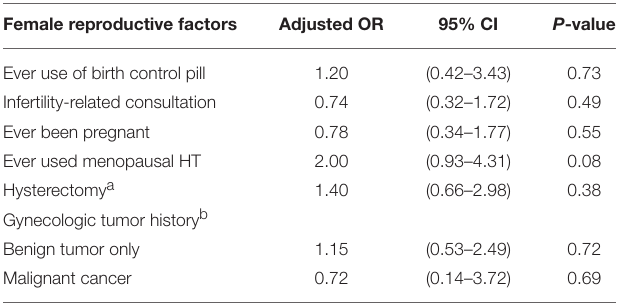
TABLE 3 | Age-adjusted comparison of key female reproductive cancer risk factors between patients with DM2 vs. DM1. Female reproductive